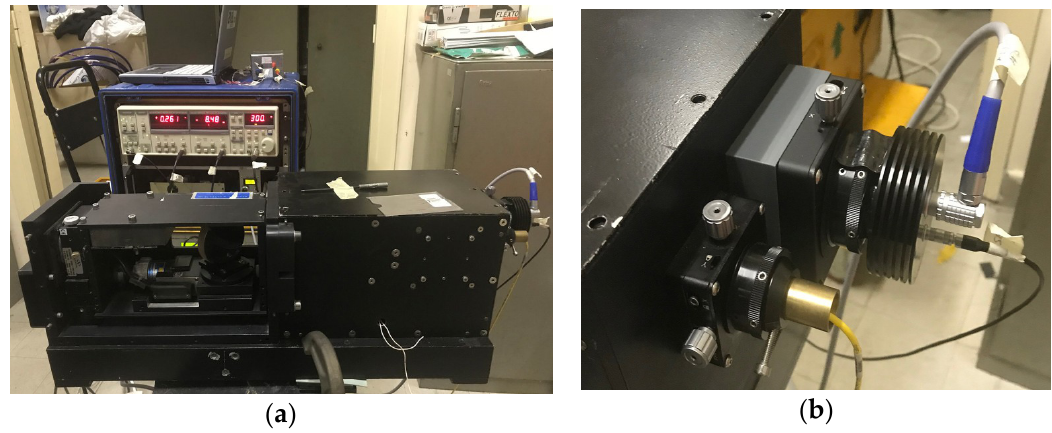
Figure 3. IR-ITR scanner prototype: ( a ) the optical head and the electronic elements in the background; ( b ) a detail of the launching fiber, directly connected to the IR laser source, and the IR